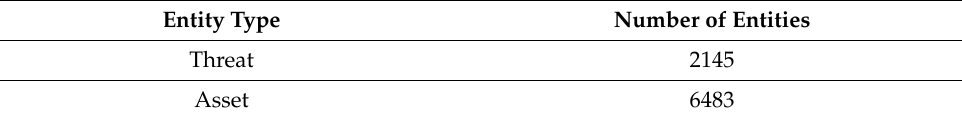
Table 10. Entities extracted in TL dataset.